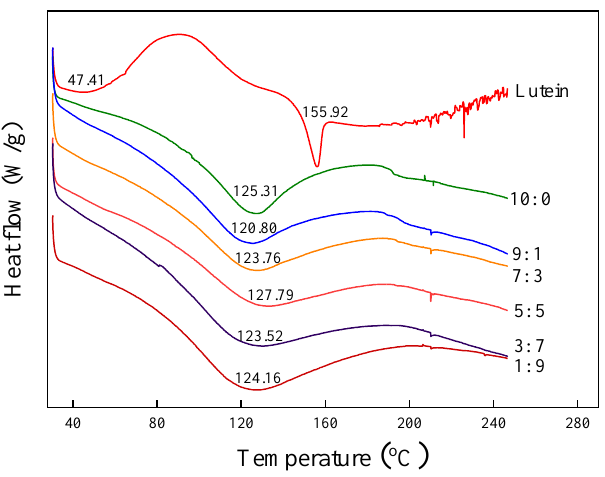
Figure 5. DSC thermograms of sodium caseinate-acetylated mung bean starch–lutein microcapsules. 10:0, 9:1, 7:3, 5:5, 3:7, and 1:9, respectively, represent the weight ratio of sodium caseinate and acetylated mung bean starch.